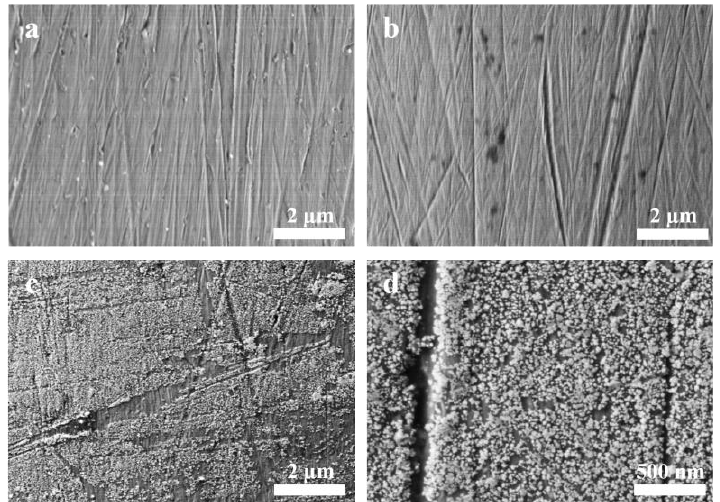
Figure 1. SEM images of ( a ) CE; ( b ) Inano-Ag-IE, and ( c ) Ag-CE electrode bodies obtained by our research group; ( d ) Enlarged image of Ag-CE electrode body.